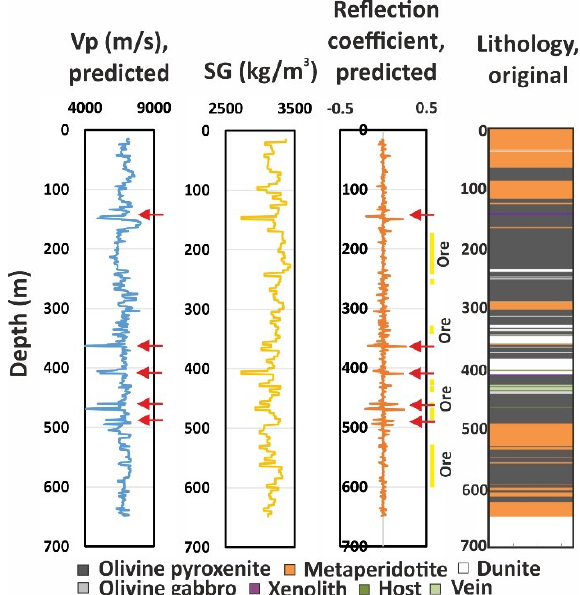
Figure 7. Predicted Vp log, measured SG log and calculated reflection coefficient log derived from predicted Vp and measured SG for borehole KV148 that did not originally contain measurements for seismic velocities. The prediction is from run 9 (Table 2). The last column shows the original lithology for the borehole KV148. Red arrow indicate the reflections discussed within the text.